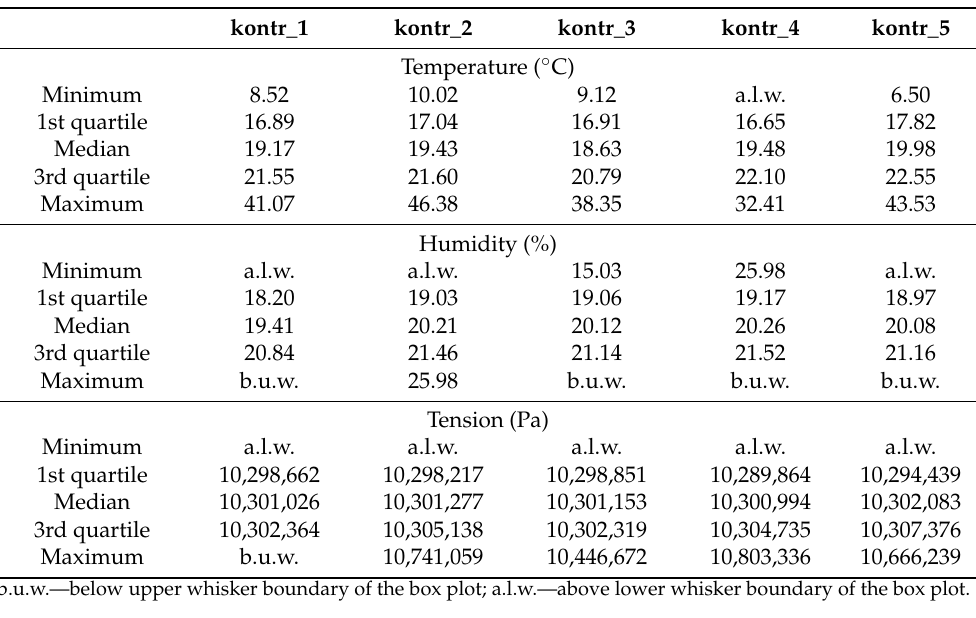
Table 2. Summary statistics for temperature, humidity and pressure for the different contractors (kontr).